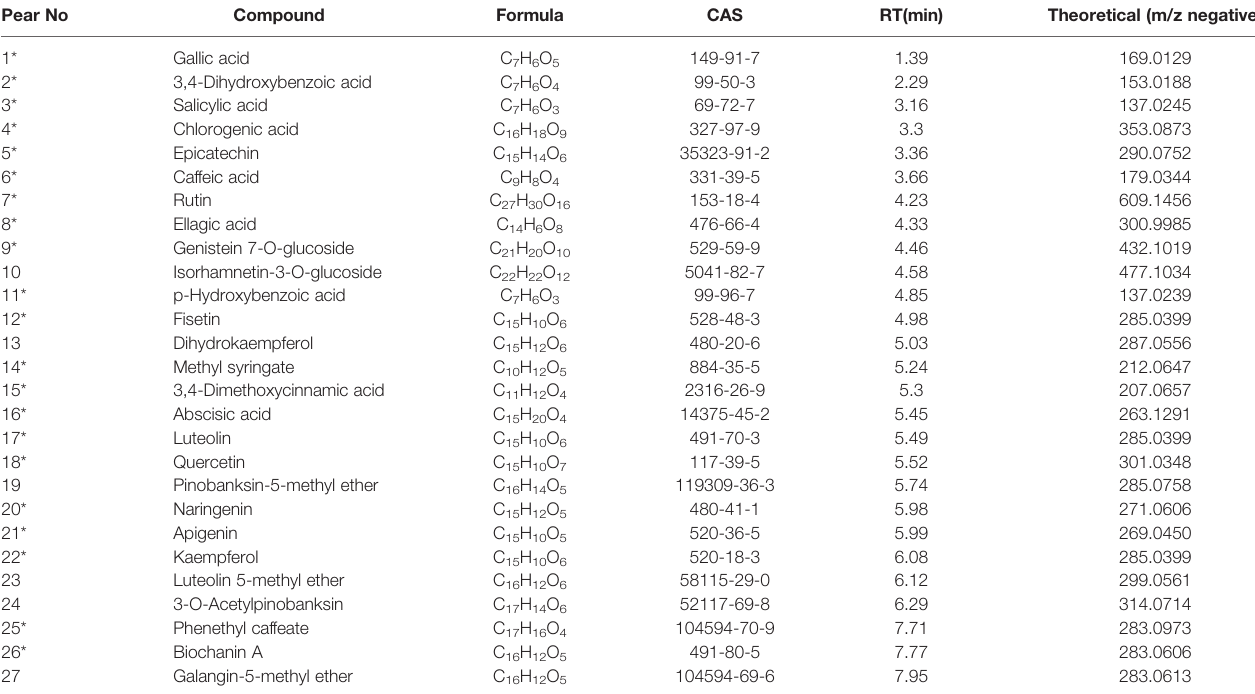
TABLE 1 | Compounds detected in Citrus nectars and honeys in negative ion mode. Pear No Compound